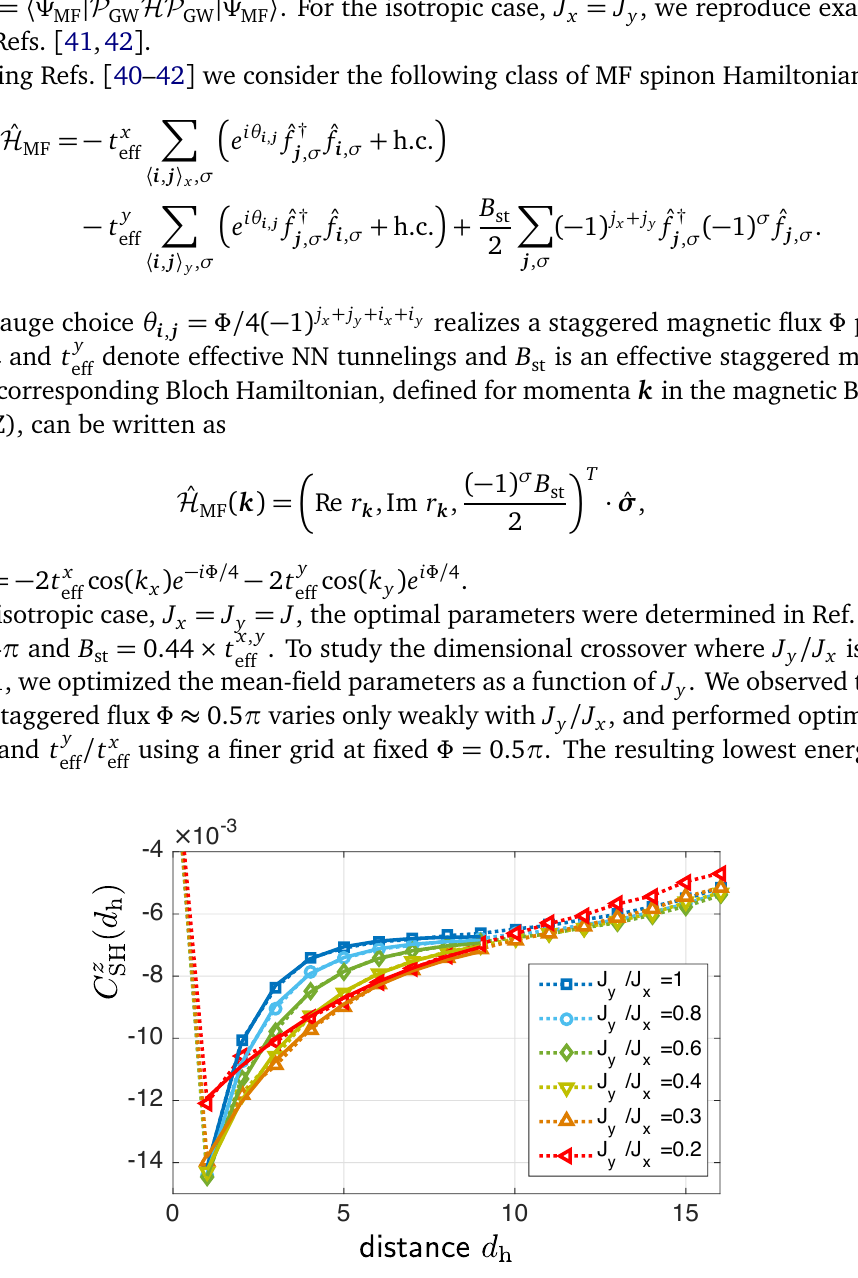
( d ) is calculated for h SH = 40, L = 3, S z = 1 / 2 and x y + A e − d h /ξ which we used to 1 2